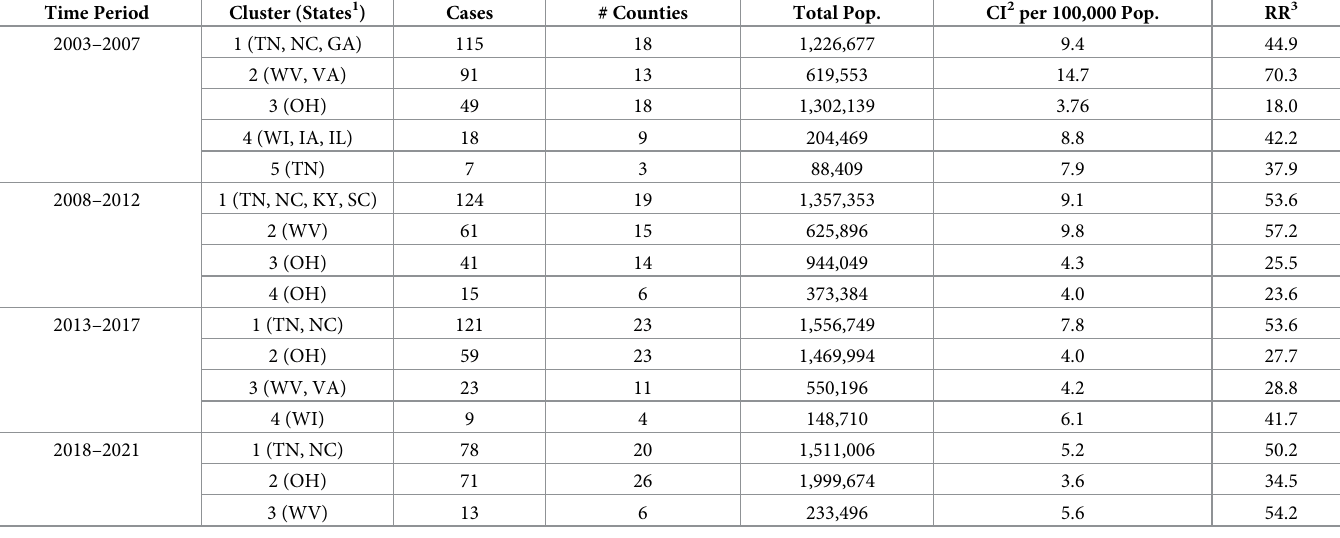
1 See Fig 1 for state abbreviations 2 Cumulative incidence 3 Risk ratio